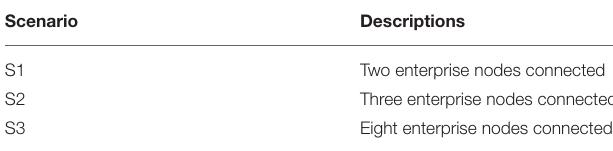
Table 1 | Test scenario